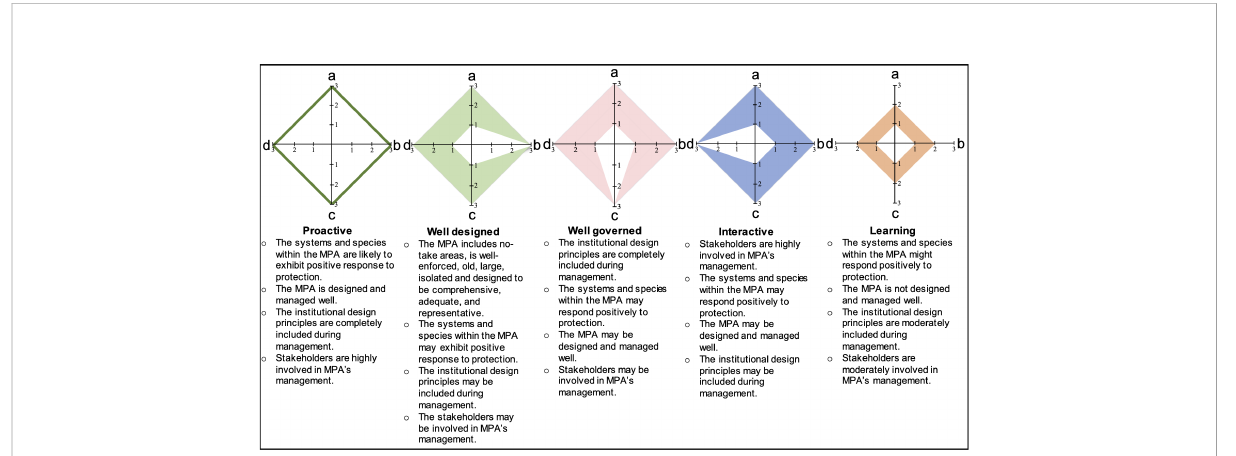
FIGURE 3 Scenario names, de fi nitions, and fi gures; “ a ” represents the attributes of the species or ecosystem within the MPA, “ b ” represents the attributes of the MPA, “ c ” represents the institutional design principles, and “ d ” represents